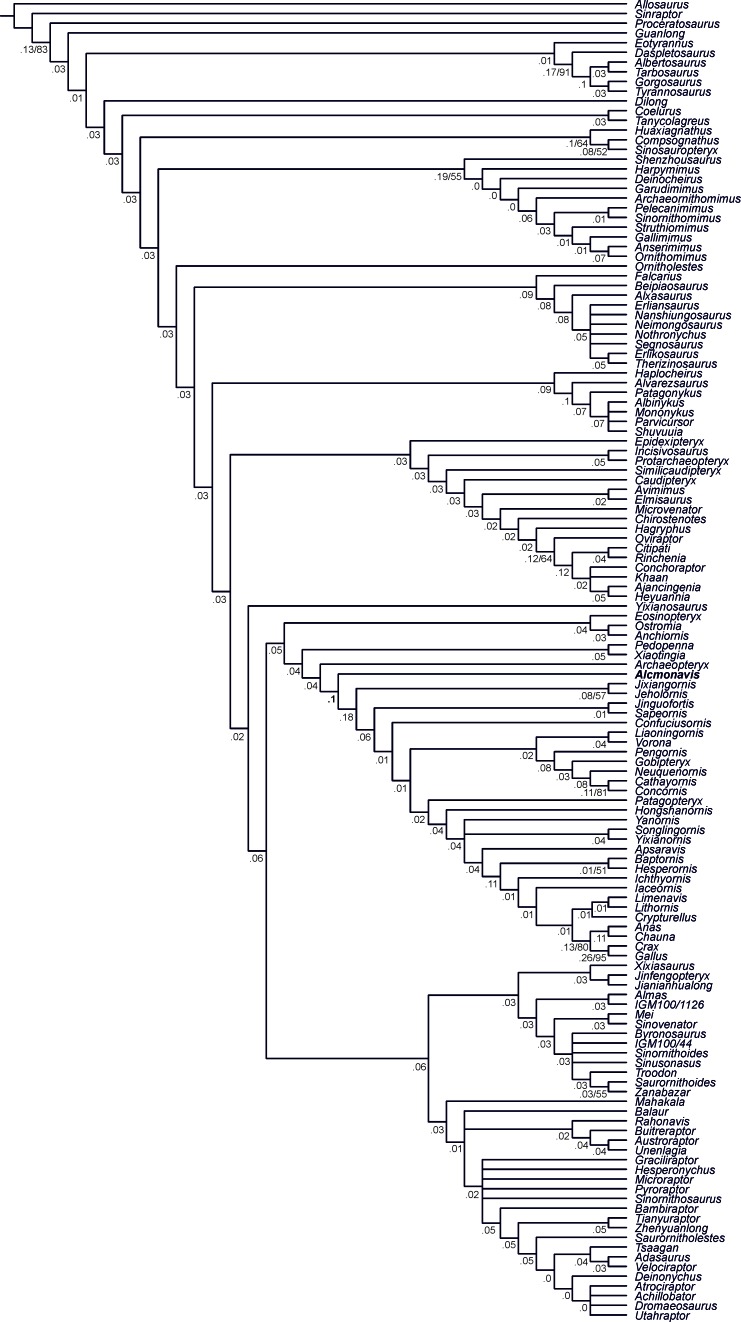
Strict consensus tree of the analysis using implied weights with Bremer support and Bootstrap values for clades with a support of 50% or more indicated.